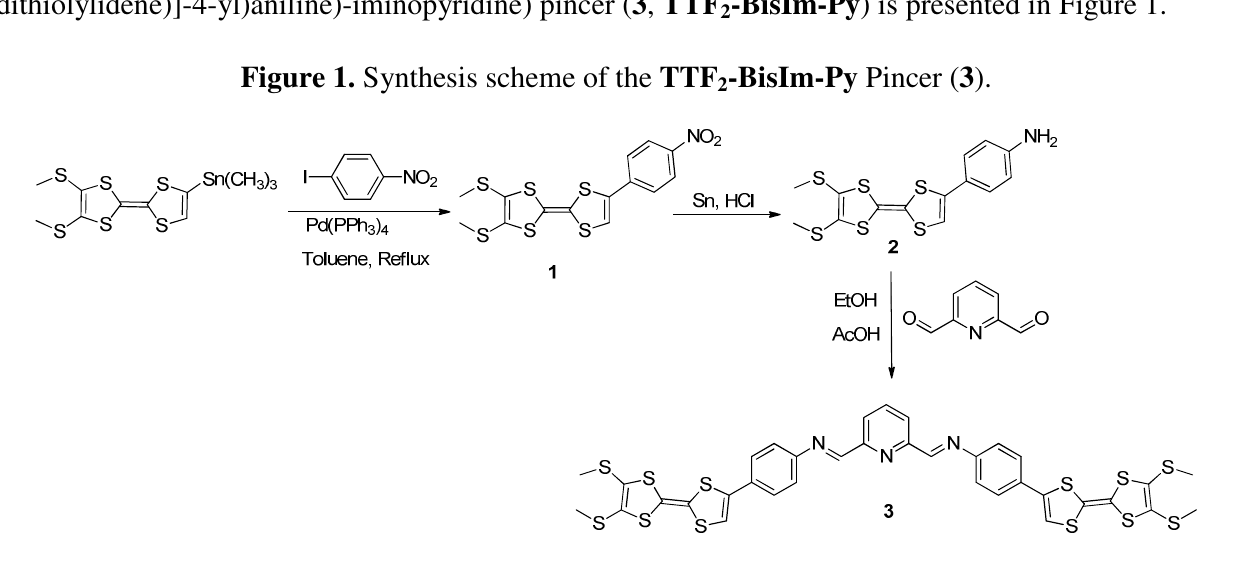
Figure 1. Synthesis scheme of the TTF